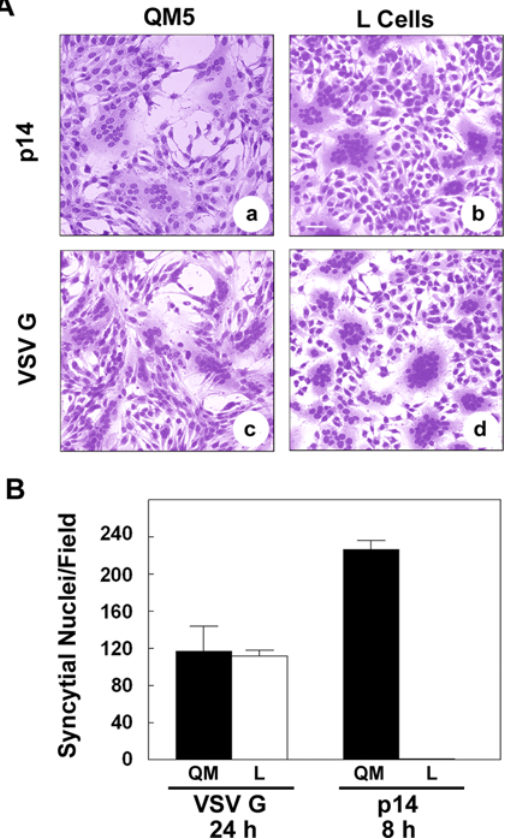
Figure 5. Fusion efficiencies in cadherin-containing and cadherin-deficient cell types. (A) QM5 and L cells were transfected with p14 or VSV G, cultured under normal calcium conditions, then fixed and Giemsa stained at 8 (panel a) or 24 (panels b–d) h post- transfection to detect multinucleated syncytia. Scale bar=50 m m. (B) QM5 and L cells were transfected with VSV G or p14, cultured under normal calcium conditions, and the average number of syncytial nuclei per field was determined from Giemsa-stained monolayers at the indicated times post-transfection. Values represent the mean 6 S.D. from a representative of two separate experiments conducted in triplicate.